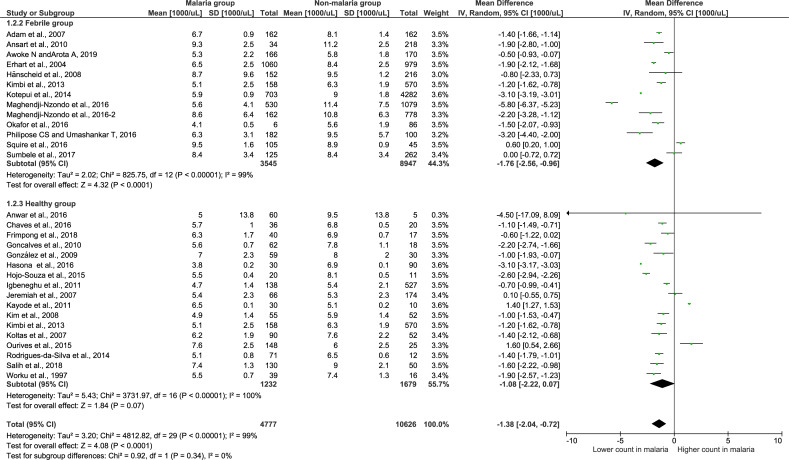
Subgroup analysis of the total leukocyte count.Forest plot of the subgroup analysis showing the total leukocyte count in malaria compared with the febrile and healthy groups. [1000/μL] refers to 1000 per microliter; “IV" in "IV, Random” refers to Inverse variance; "Total" in top row refers to number of patients included; A green square in the horizontal line refers to the mean difference for each of included study.